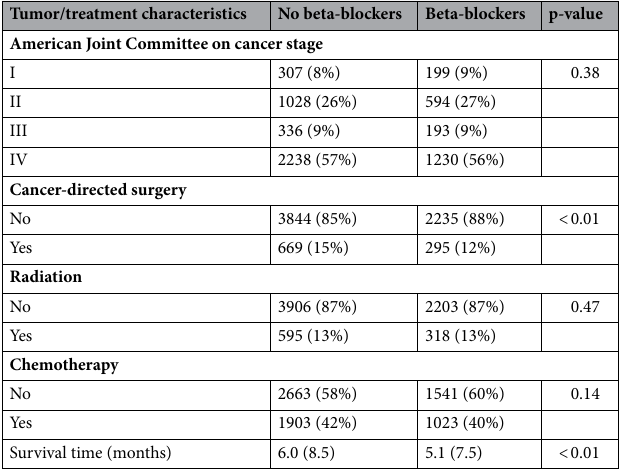
Table 2. Tumor and Stage Characteristics for those using beta blockers prior to diagnosis. Percentages or standard deviations are expressed in parentheses.